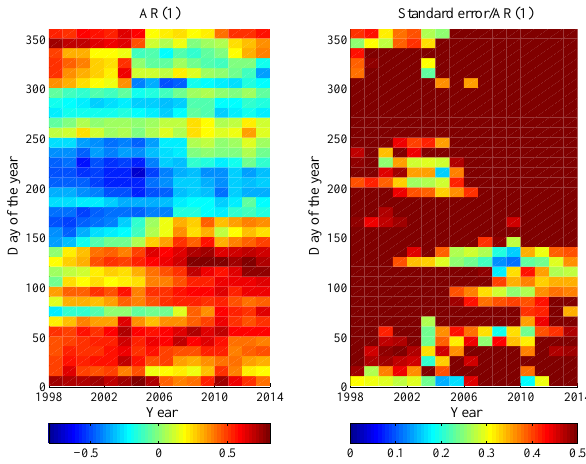
Figure 13. Mean lag 1 autocorrelation of the return map across all starting points within the cycle using a sliding window of 20years. This is the same as Fig. 12 with the mean taken along the y axis. Estimated autocorrelation is still very uncertain. The mean is the solid line with the dotted lines being the mean plus or minus the standard error. The mean value across all years 0 . 16 ± 0 . 26 which corresponds to a (very uncertain) timescale of τ ≈ 0 . 55